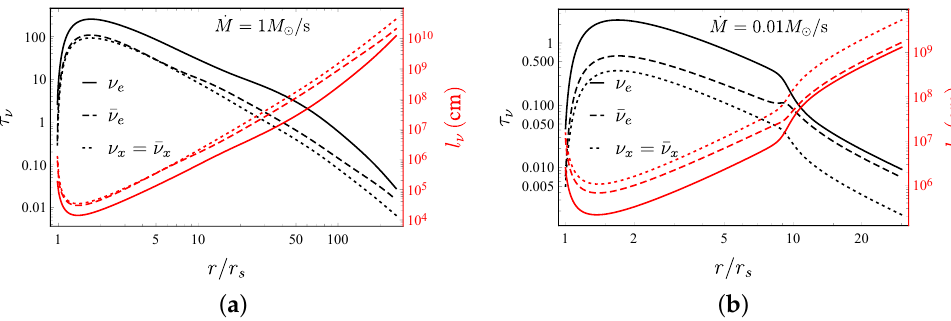
Figure 4. Total optical depth (left scale) and mean free path (right scale) for neutrinos and antineu- trinos of both flavors between the inner radius and the ignition radius for accretion disks with ( a ) ˙ M = 1 M (cid:12) s − 1 and ( b ) 0.01 M (cid:12) s − 1 .